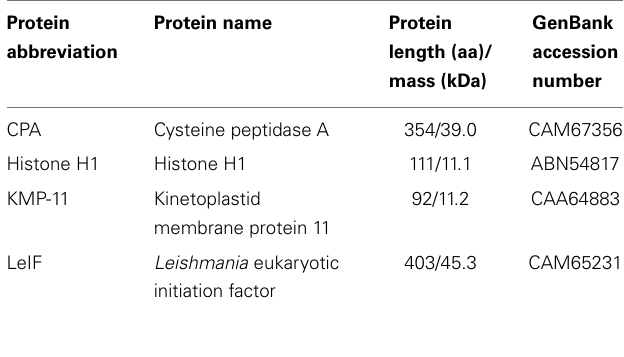
Table 1 | L. infantum proteins selected as candidate antigens for epitope mapping